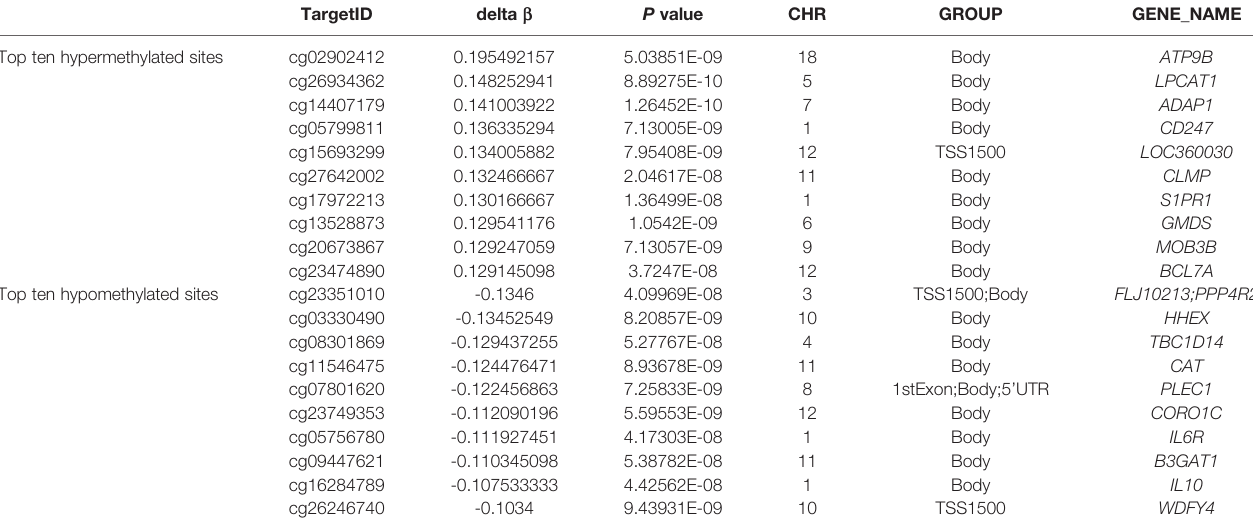
TABLE 2 | Top ten hyper- and hypo- methylated sites in whole blood genome in